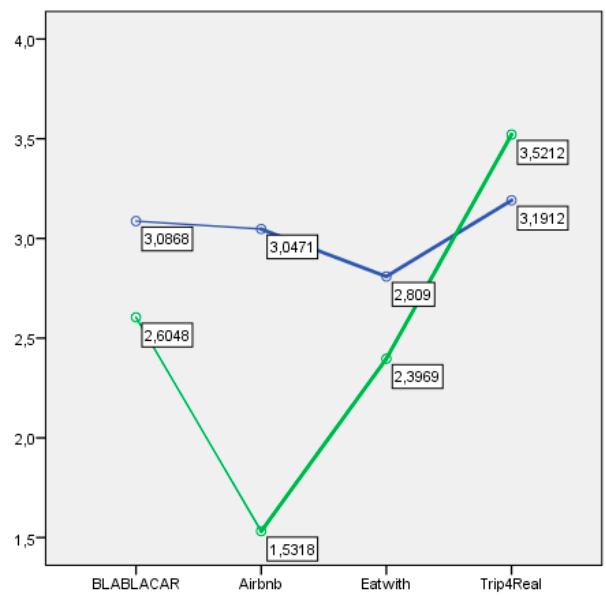
Figure 1. Intention of recommending means. Green line: X generation, Blue line: Y generation.